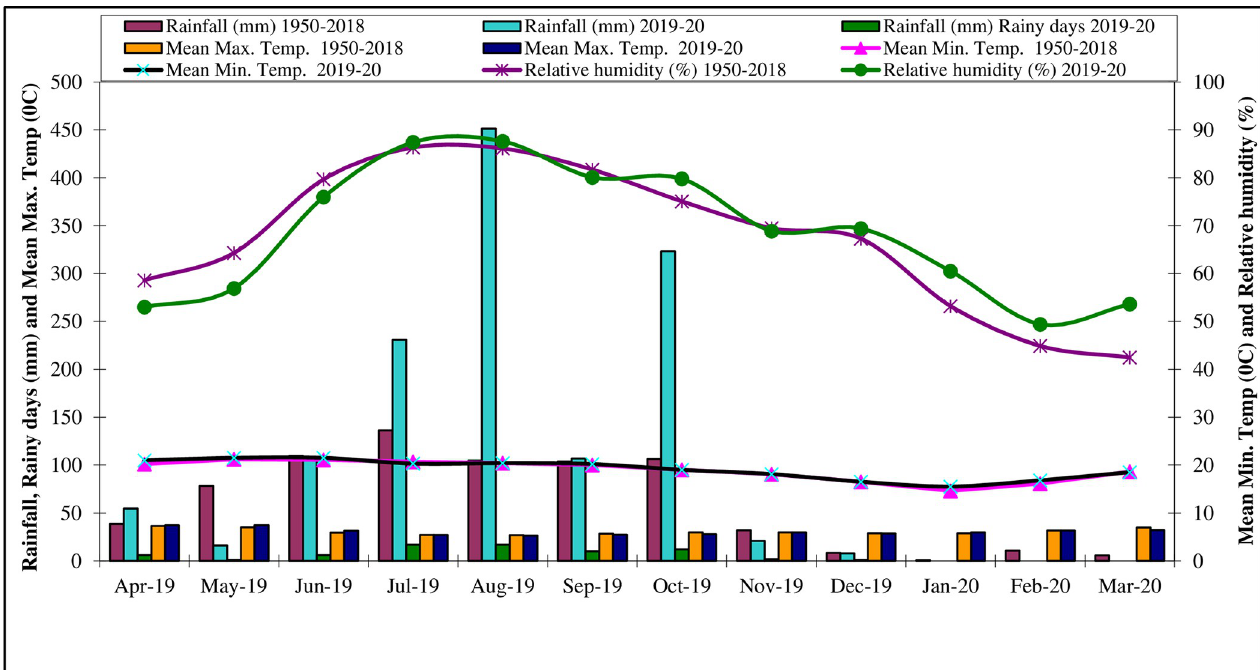
Fig 1. Monthly meteorological data during crop growth period (2019–20) and the average of 69 years (1950–2018) at Main Agricultural Research Station, Dharwad.